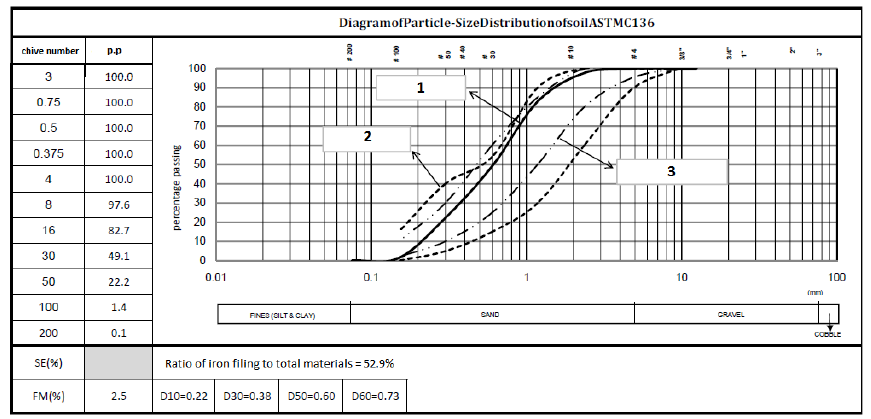
Fig. 7. Hydrocyclone Grading curve with two inlet gates (1: Grading curve, 2: Grading enve- lope according to Building Regulations of Iran [9], 3: Grading envelope according to Iranian Road Construction